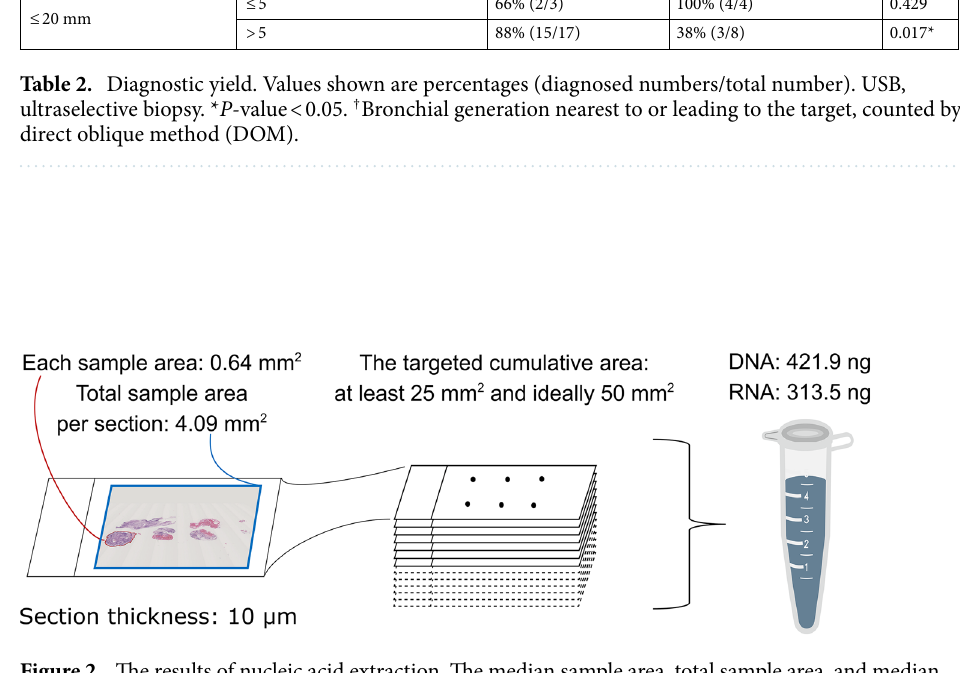
Figure 2. The results of nucleic acid extraction. The median sample area, total sample area, and median quantities of DNA and RNA are presented as representative data. As the targeted area was at least 25 mm 2 and ideally doubled, the calculated number of sections in this figure was at least seven and, ideally, 13. The quantity of extracted nucleic acid was greater than required (10 ng, according to the manufacturer’s